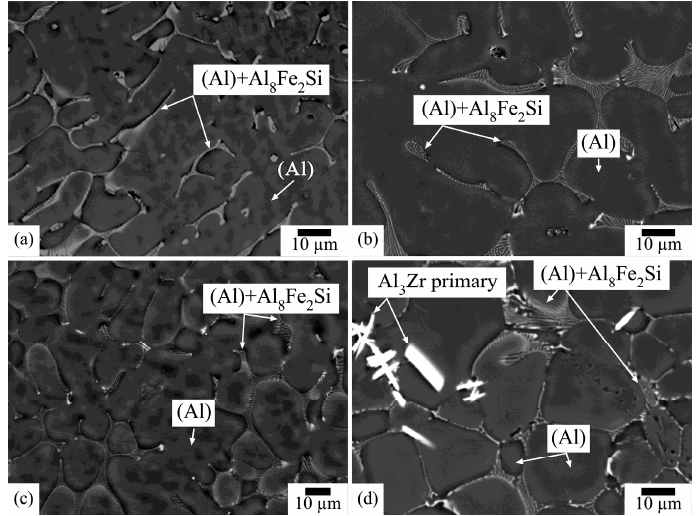
Figure 3. Microstructure of as-cast alloys with different contents of Zr: ( a ) Al-1%Fe-0.5%Si; ( b ) Al-1% Fe-0.5% Si-0.15% Zr; ( c ) Al-1% Fe-0.5% Si-0.3%Z r; ( d ) Al-1% Fe-0.5% Si-0.6% Zr.